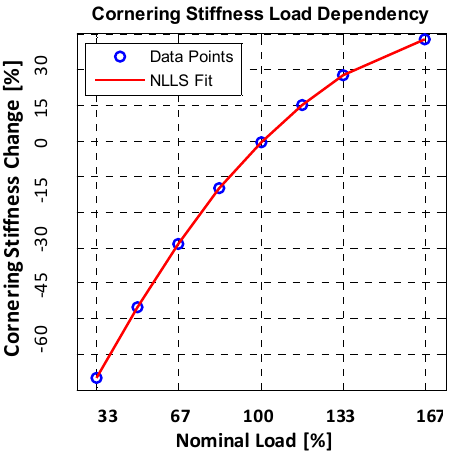
Figure 13. Influence of normal load on the tire cornering stiffness.